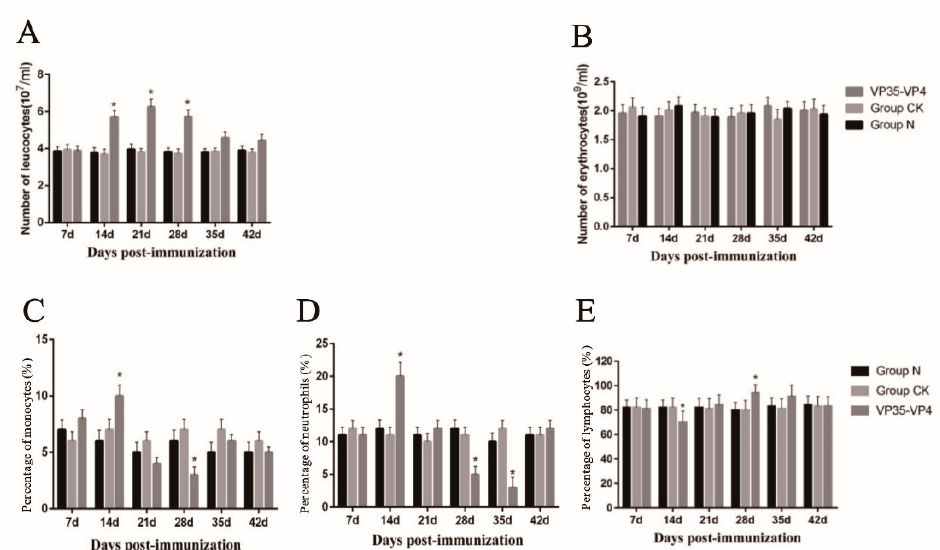
Figure 5. The changes of hematocyte numbers and differential leucocyte count in peripheral blood of grass carp after immunized with oral vaccine. ( A – B ) The hematocyte number changes of white blood cells and red blood cells in immunized grass carp, respectively. ( C – E ) Differential leucocyte count changes of monocytes, neutrophils and lymphocytes in immunized grass carp, respectively. * significant difference ( p < 0.05). The significant difference is compared against the group CK group.